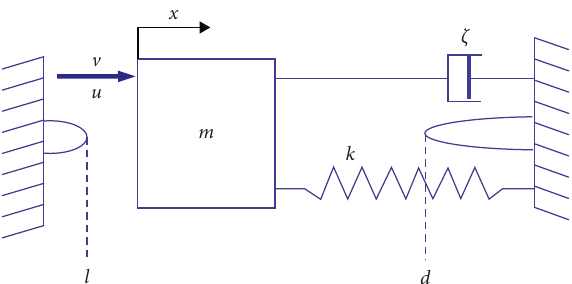
Figure 1: A 1-DoF impact mechanical oscillator under two asymmetric rigid